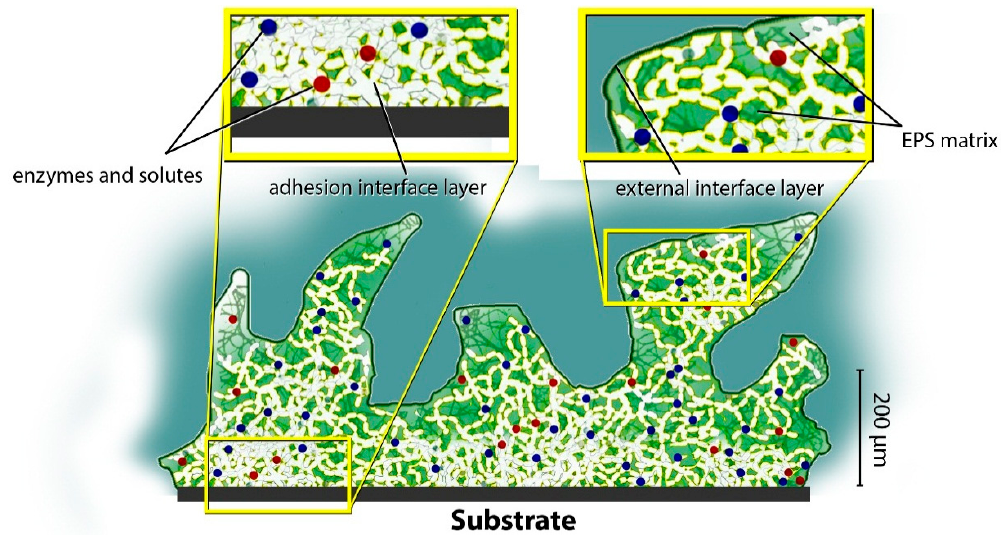
Figure 11. Main features and components of a biofilm layer.